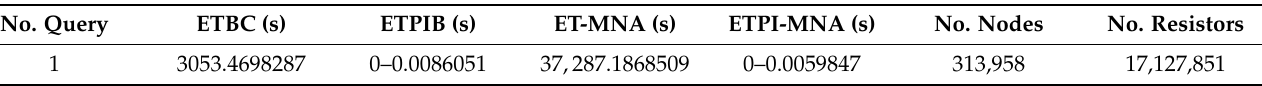
Figure 15. The 5 DOF manipulator’s collision-free path (sequence of configurations). A = ( − 50 ◦ , − 5 ◦ ,0 ◦ , − 20 ◦ , − 20 ◦ ) and B = ( 40 ◦ , − 5 ◦ ,10 ◦ , − 80 ◦ , − 70 ◦ ) . Table 6. Execution time of case study 2 (5 DOF manipulator). ETBC: execution time of bitmap creation, ETPIB: execution time per iteration in the bitmap creation process, ET-MNA: execution time of MNA creation, ETPI-MNA: execution time per iteration in the MNA creation process.